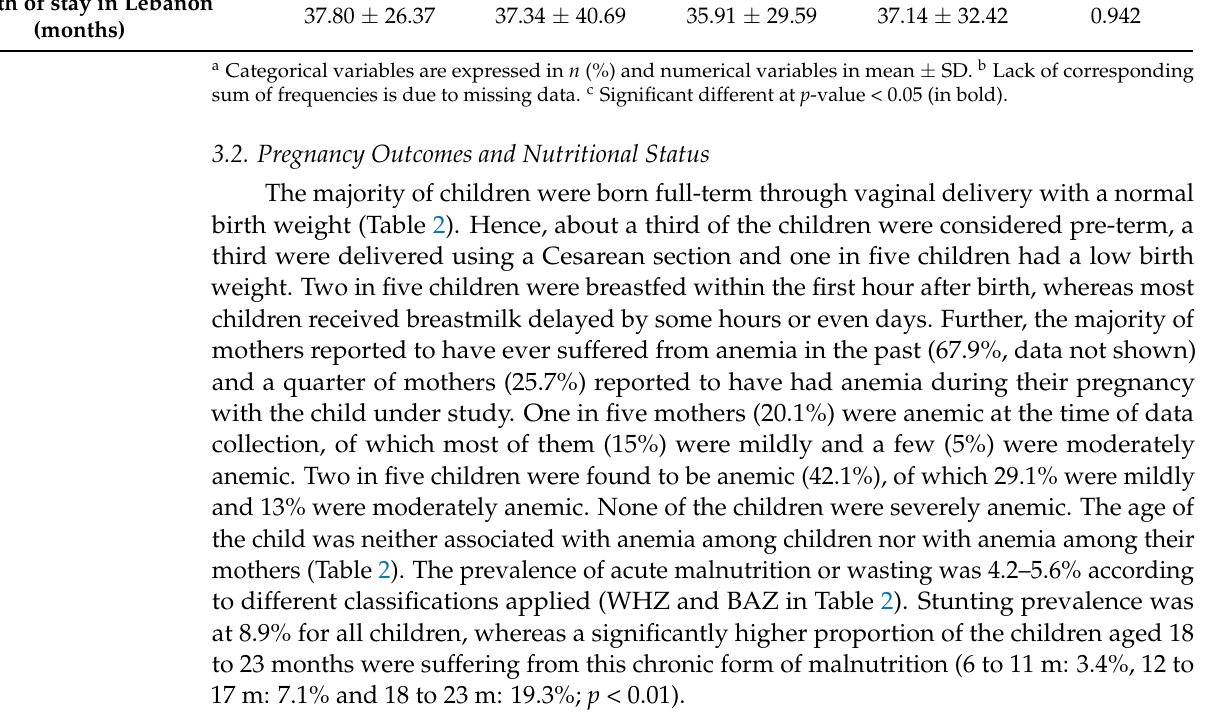
Table 2. Pregnancy outcomes and nutritional status of Syrian refugee children aged 6 to 23 months and their